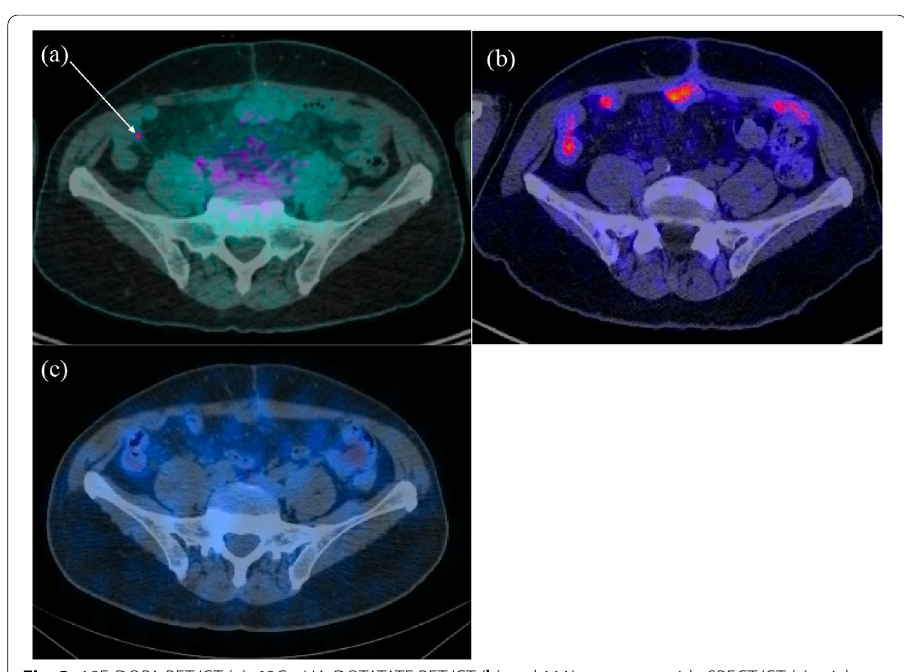
Fig. 3 18F-DOPA PET/CT ( a ), 68Ga-HA-DOTATATE PET/CT ( b ) and 111In-pentetreotide SPECT/CT ( c ) axial images of the pelvis. Intensely avid 0.3-cm lymph node within the right lower quadrant mesentery adjacent to the neoterminal ileum demonstrated intense 18F-DOPA activity ( a ), but no 68Ga-HA-DOTATATE ( b ) or 111In-pentetreotide ( c )